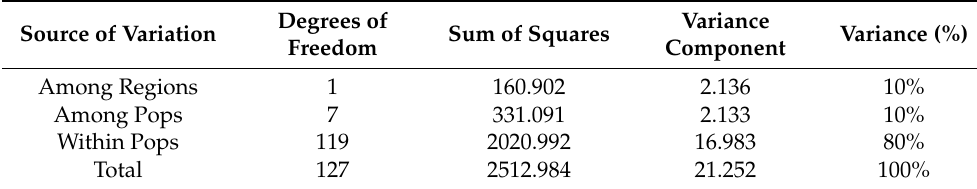
Figure 4. Graphic representations of the structure of the populations of Raddia created using the Gaussian cluster analysis on ISSR data, showing the proportion of gene pools in each population, with different colors representing different gene pools. Colors are consistent with Figure 3b. The AMOVA from all populations resulted in Φ PT = 0.20, equally divided into popula- tion divergence and region divergence ( p = 0.001 for both), with 80% of the total variation within populations (Table 2). Table 2. Analysis of molecular variance (AMOVA) for Raddia populations. Degrees of Variance Source of Variation Sum of Squares Variance (%) Freedom Component Among Regions 1 Among Pops Within Pops